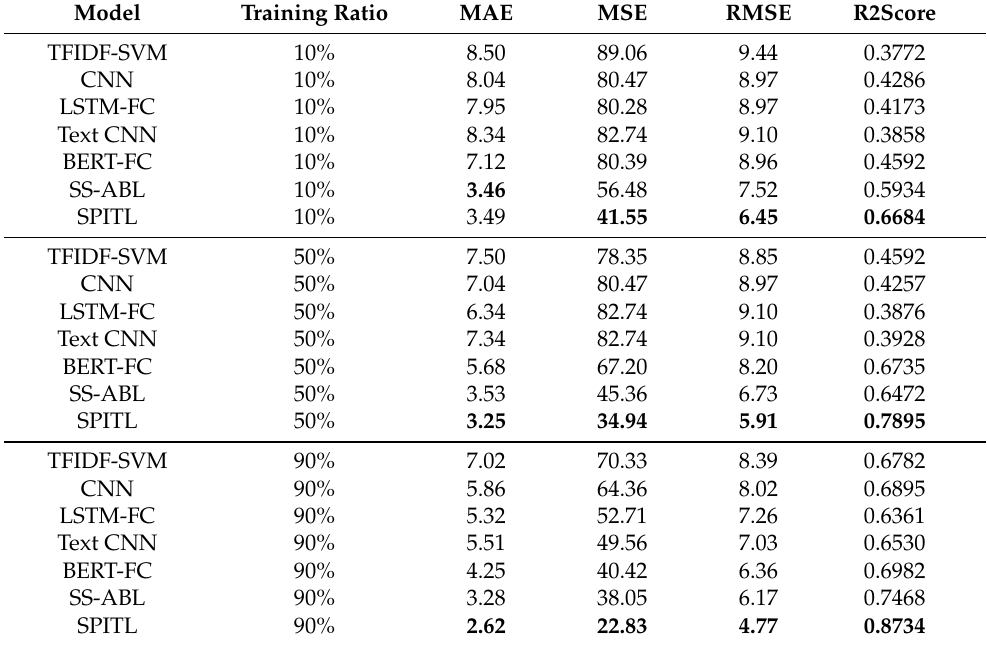
Table 2. Performance results for different methods.